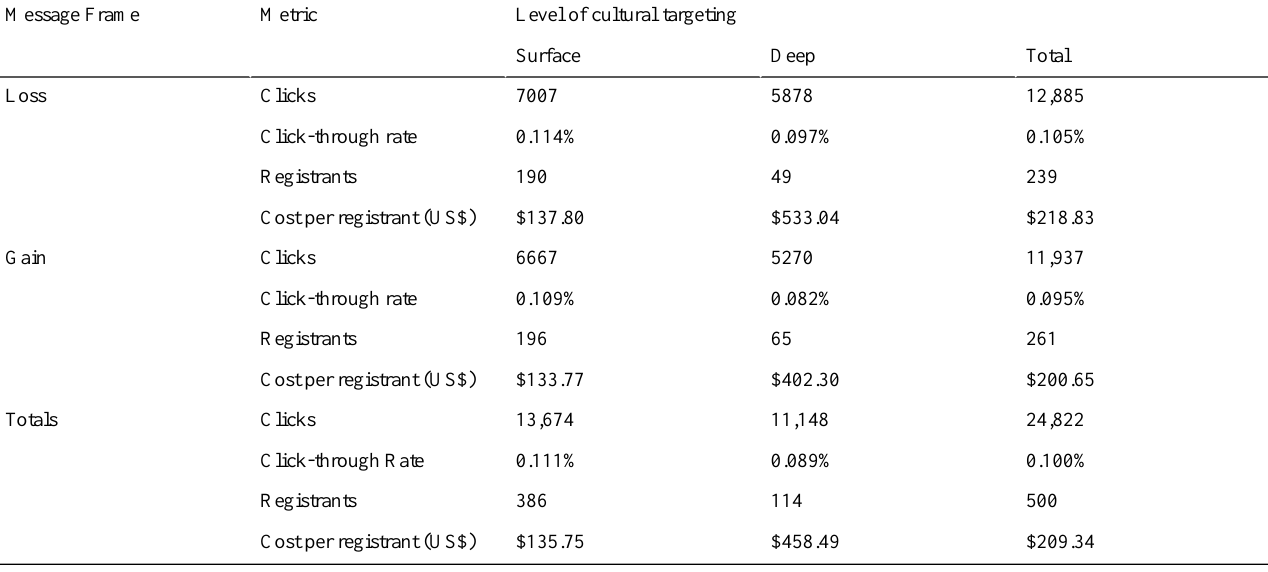
Table 3. Banner advertising results by message framing and cultural